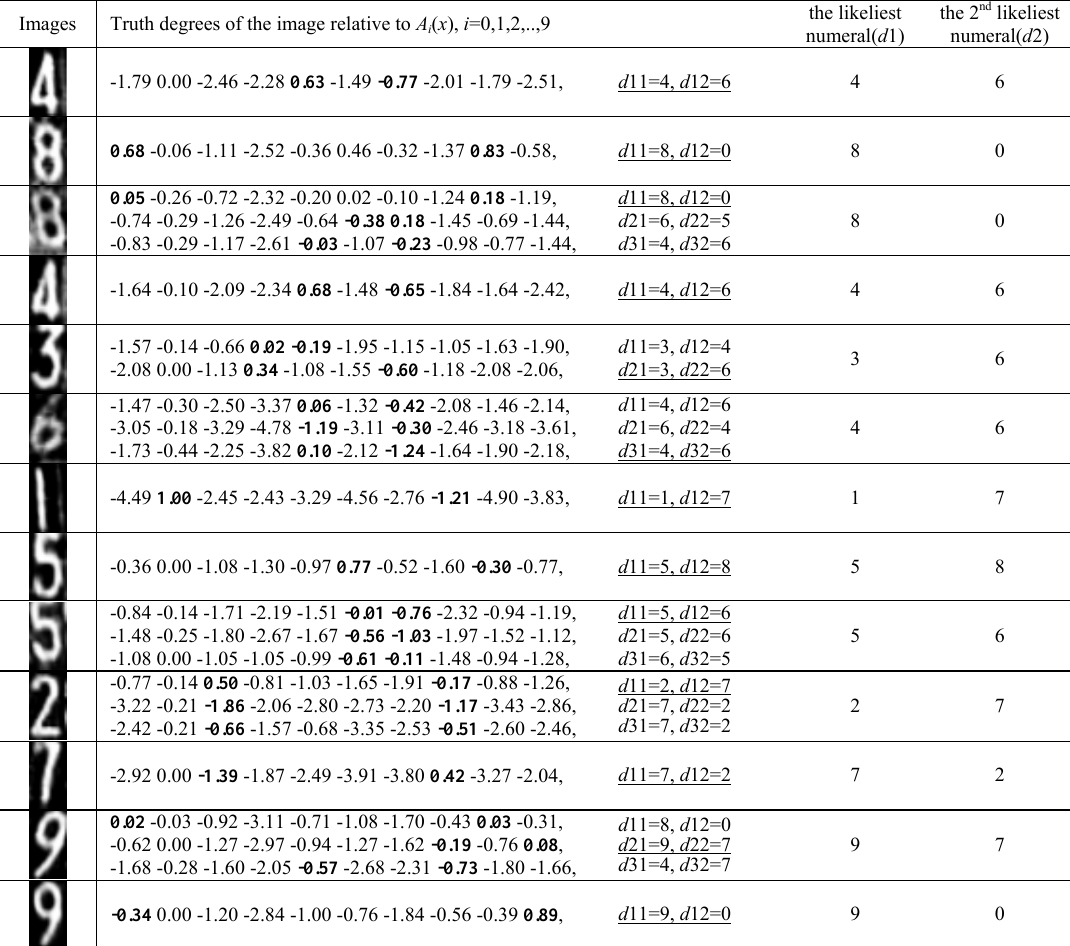
Table 1. DNRBM recognition results for some images.